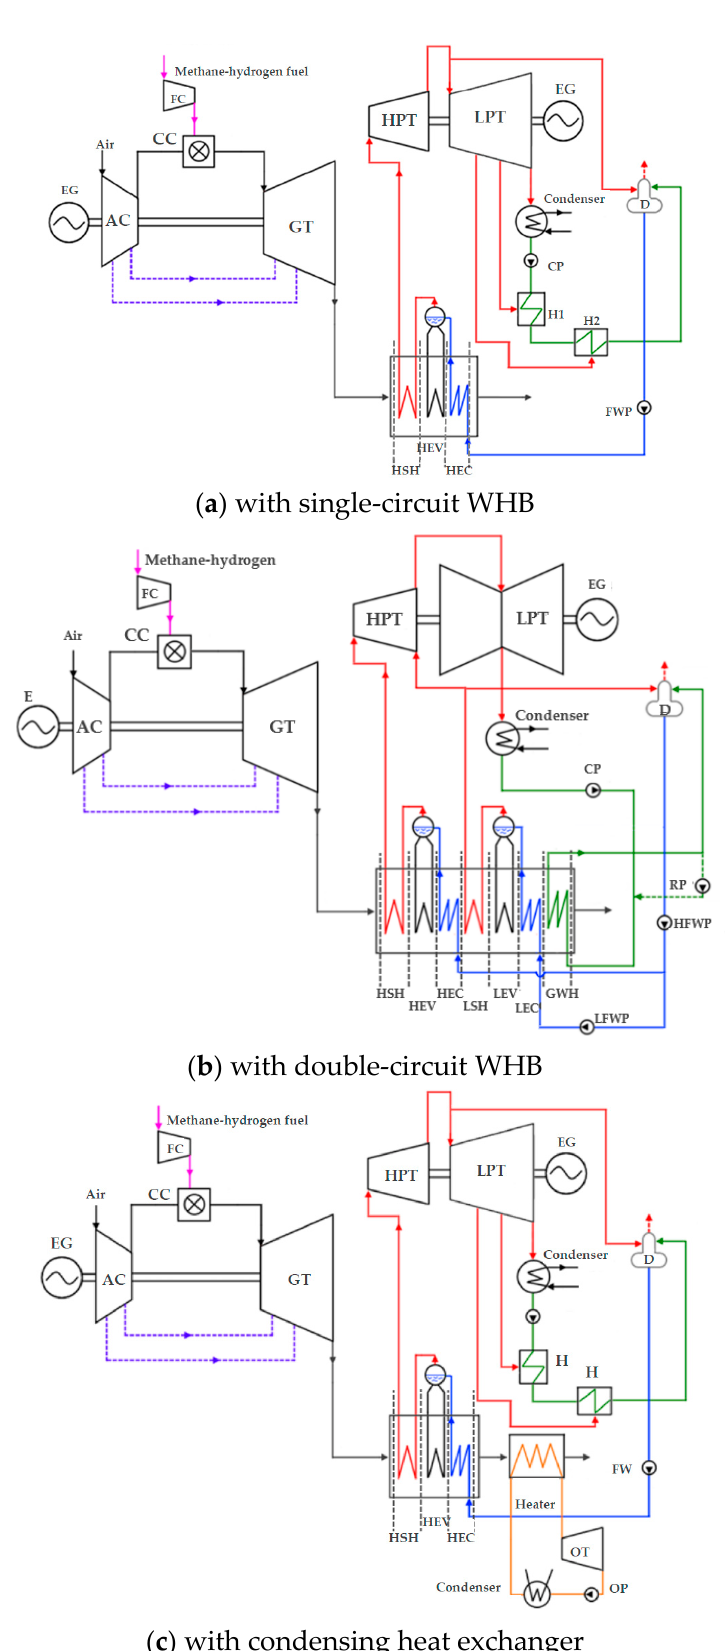
Figure 1. Combined cycle plant.